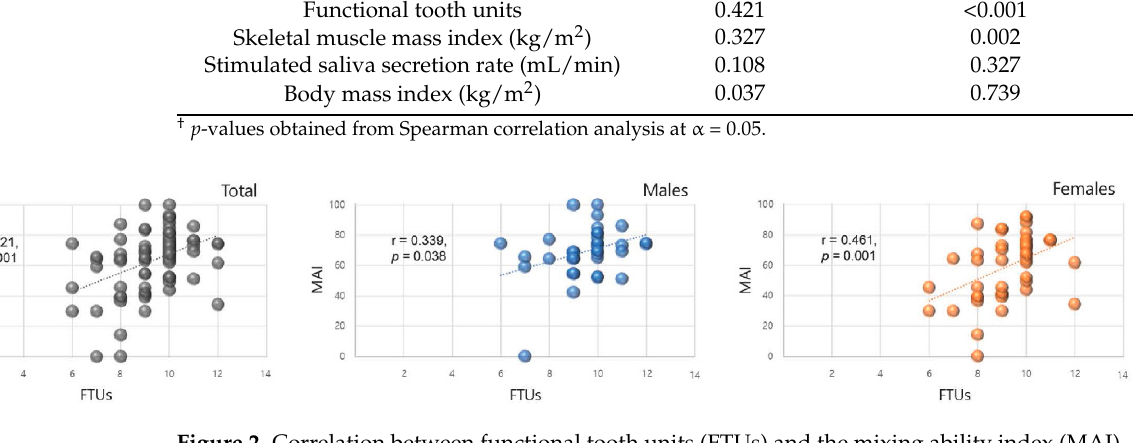
Figure 3. Correlation between the skeletal muscle mass index (SMI) and the mixing ability index (MAI). Figure 4. Correlation between the skeletal mass index (SMI) and functional tooth units (FTUs). Table 2. Mixing ability index-related variables. Variables